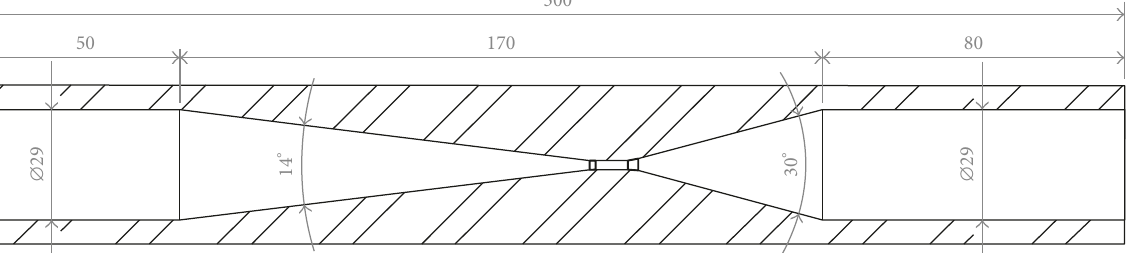
Figure 3: Cavitating venturi drawing.